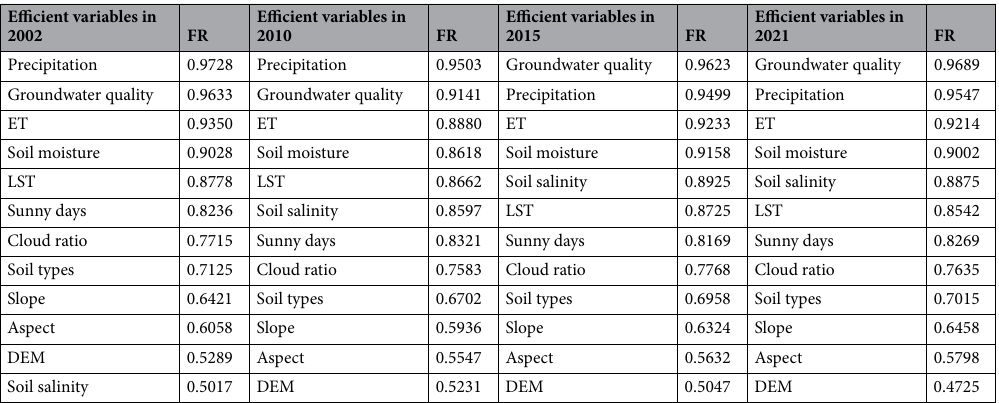
Table 10. Efficiency of different variables for AL modelling and mapping using the